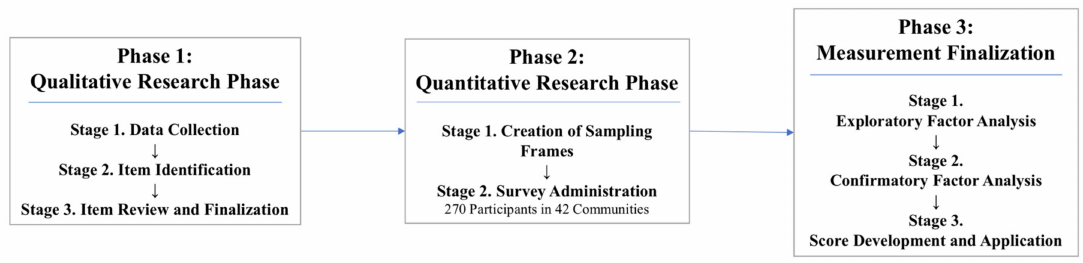
Figure 1. Flowchart for measurement